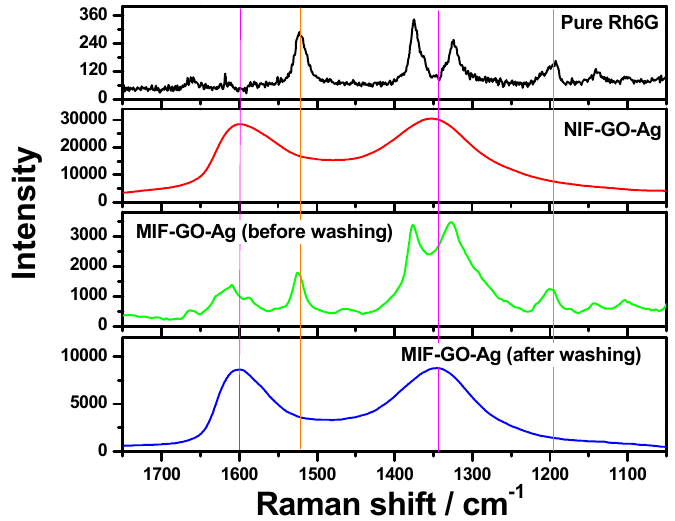
Figure 4. Raman spectra of pure Rh6G (20 μ L, 10 − 3 M) deposited on a silicon substrate (black curve), NIF@GO-AgNPs (red curve), and MIF@GO-AgNPs before (green curve) and after (blue curve) washing.